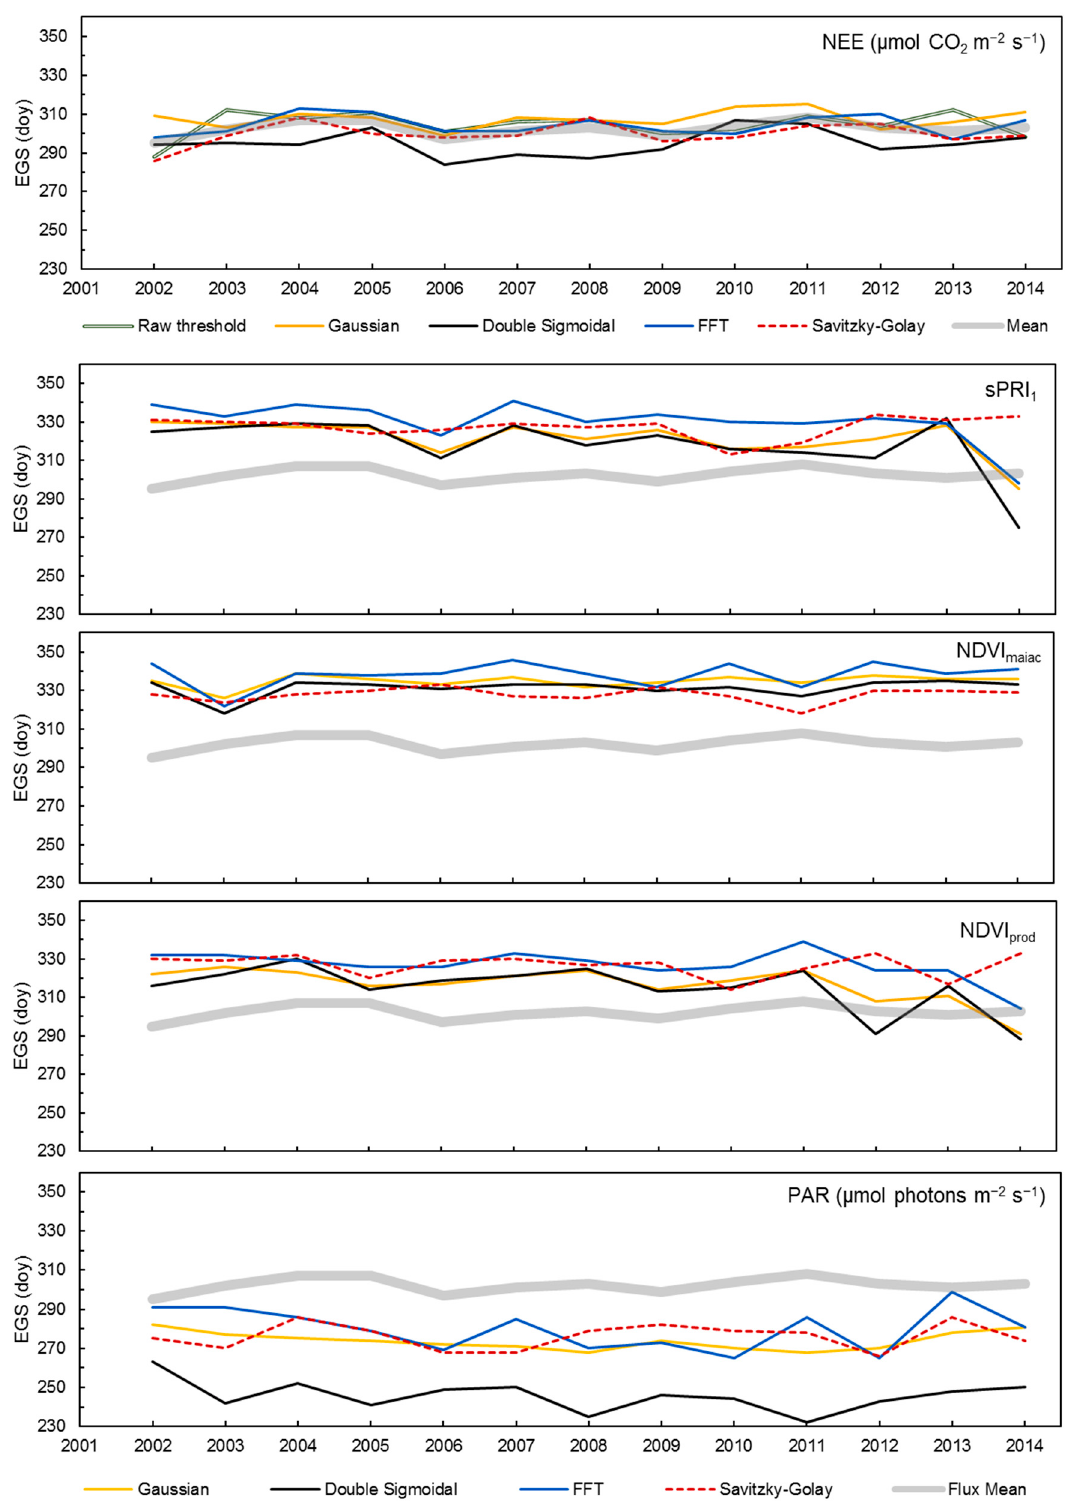
Figure 4. Estimated end of growing season (EGS) based on raw and smoothed daily Net Ecosystem Productivity (NEE) data, the three different MODIS vegetation index time series (NDVI maiac , sPRI 1 and NDVI prod ) and ground-measured photosynthetically active radiation (PAR).